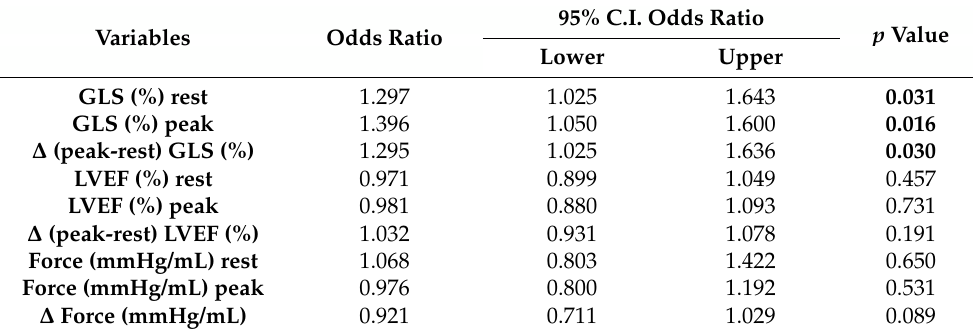
Table 4. Multivariable logistic regression analysis. Predictors of